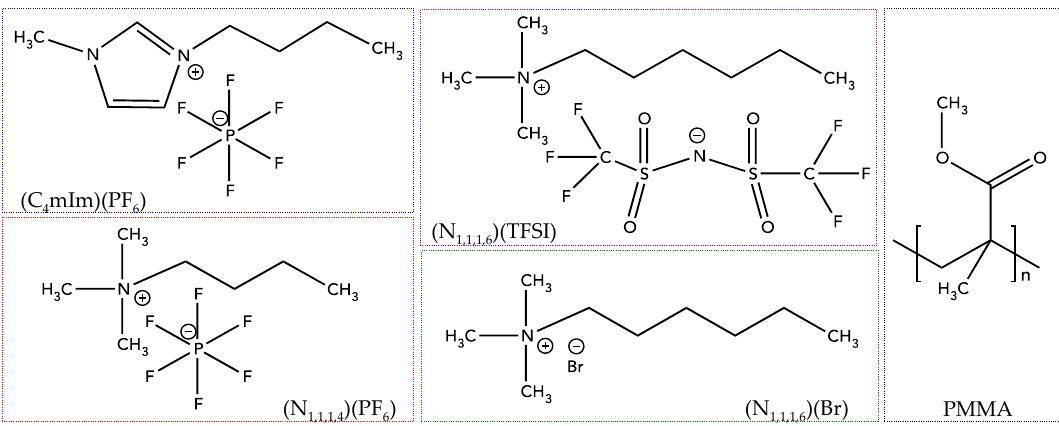
Figure 1. Chemical structures of ionic liquids (ILs) considered in this study. PMMA, poly(methyl methacrylate); TFSI, bis(trifluoromethanesulfonyl)imide; PF 6 , hexafluorophosphate; Br, Bromide.